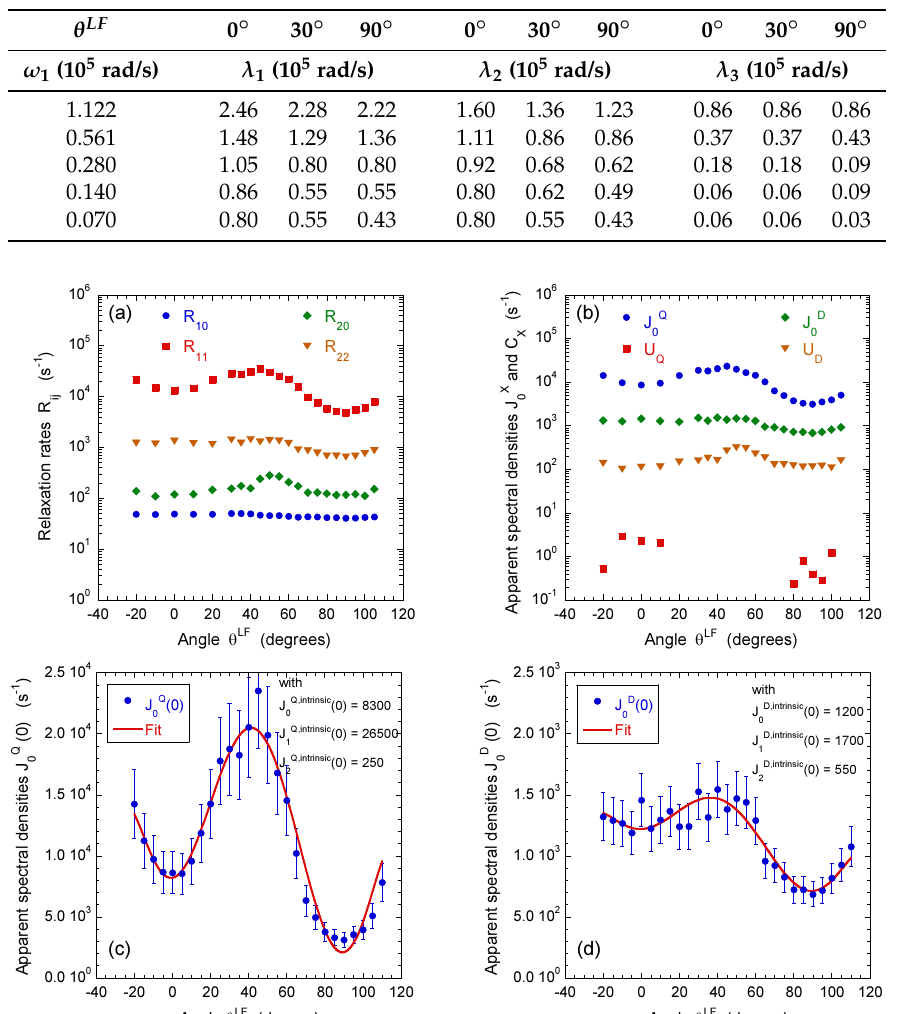
Figure 6. Influence of film orientation θ LF in the static magnetic field B 0 : ( a ) on the apparent multi-quanta relaxation rates of T 10 , T 11 ( a , s ) , T 20 and T 22 ( a , s ) coherences, noted R 10 , R 11 , R 20 and R 22 , respectively; and ( b ) on the on the apparent spectral densities J Q from these R ij values; see Equation (A24) in Appendix D. The intrinsic spectral densities J X , intr ( 0 ) and J X , intr ( 0 ) with X ∈ { D , Q } , extracted from angular variation of the apparent spectral J X , intr 2 1 ( 0 ) quantifying ( c ) heterogeneous quadripolar ( X = Q ) and ( d ) dipolar ( X = D ) relaxation densities J X 0 mechanisms (see the Appendix). Reprinted with permission from [23]. Copyright (2014) American Chemical